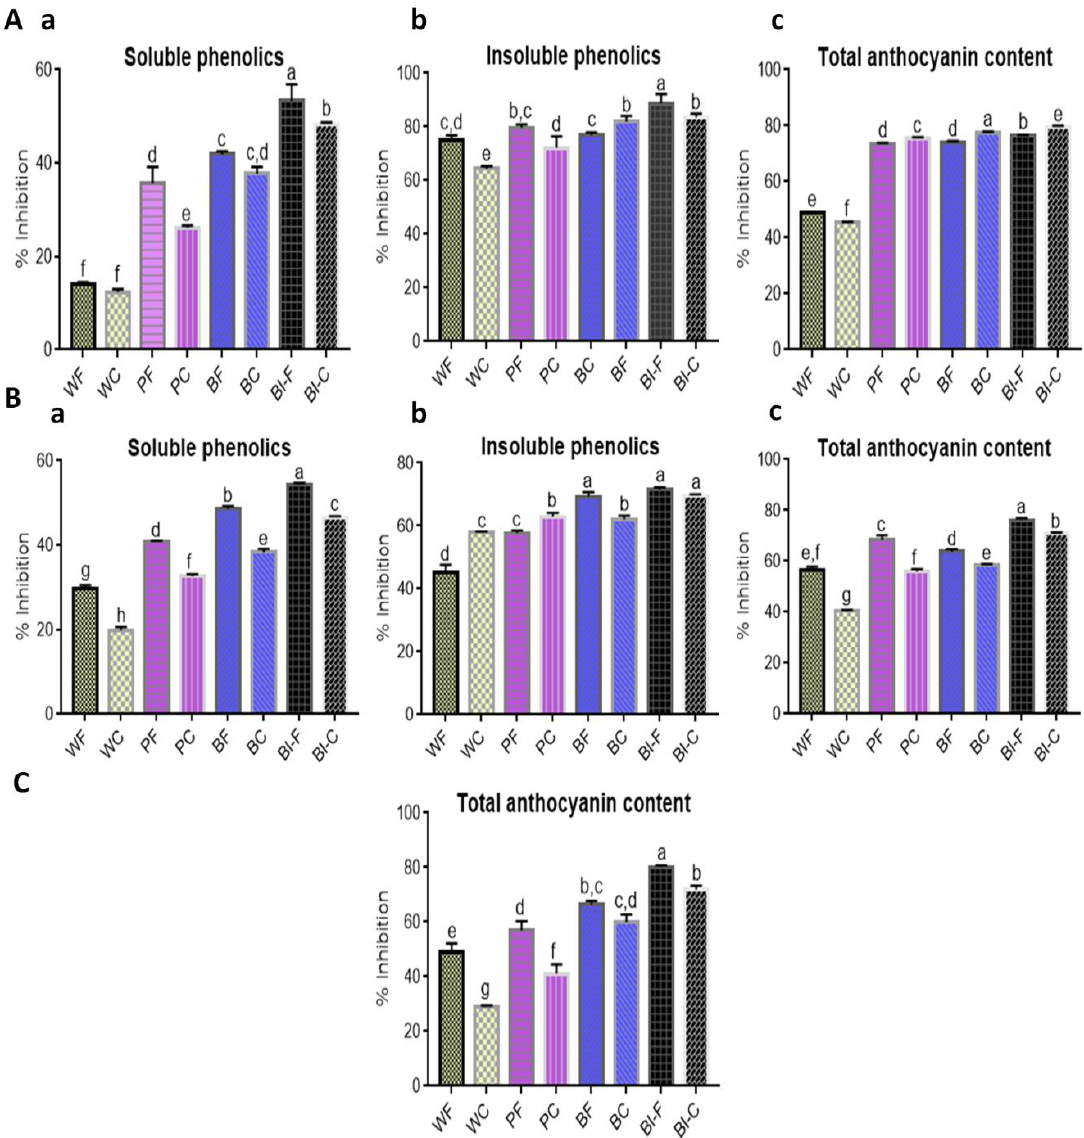
Figure 3. Antioxidant activity of flour and chapatti samples ( A ) 1, 1-diphenyl-2-picrylhydrazyl (DPPH) based antioxidant activity of (a) Soluble phenolics (b) Insoluble phenolics (c) Total anthocyanins of flour and chapatti. ( B ) 2,2 (cid:48) -azino-bis (3-ethylbenzothiazoline-6-sulfonic acid (ABTS) antioxidant activity of (a) Soluble phenolics (b) Insoluble phenolic (c) Total anthocyanins of flour and chapatti. ( C ) Photochemiluminance (PCL) based antioxidant activity of anthocyanin extracts. All values are expressed as mean ± S.D. Columns labeled with different letters are significantly different ( p < 0.05). WF-white wheat flour, PF-purple wheat flour, BF-blue wheat flour, Bl-F- black wheat flour, WC-white wheat chapatti, PC-purple wheat chapatti, BC-blue wheat chapatti and Bl-C-black wheat chapatti.